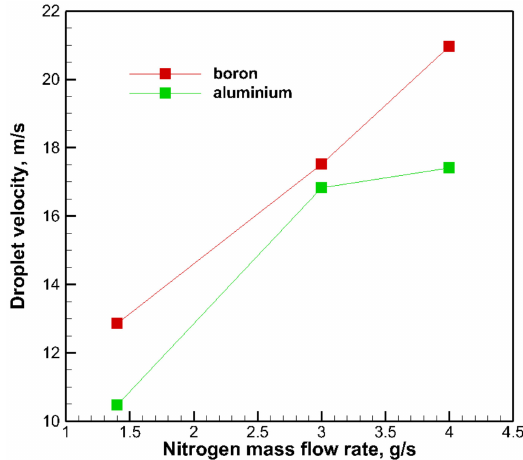
Figure 13. Droplet velocity with different particle addition.